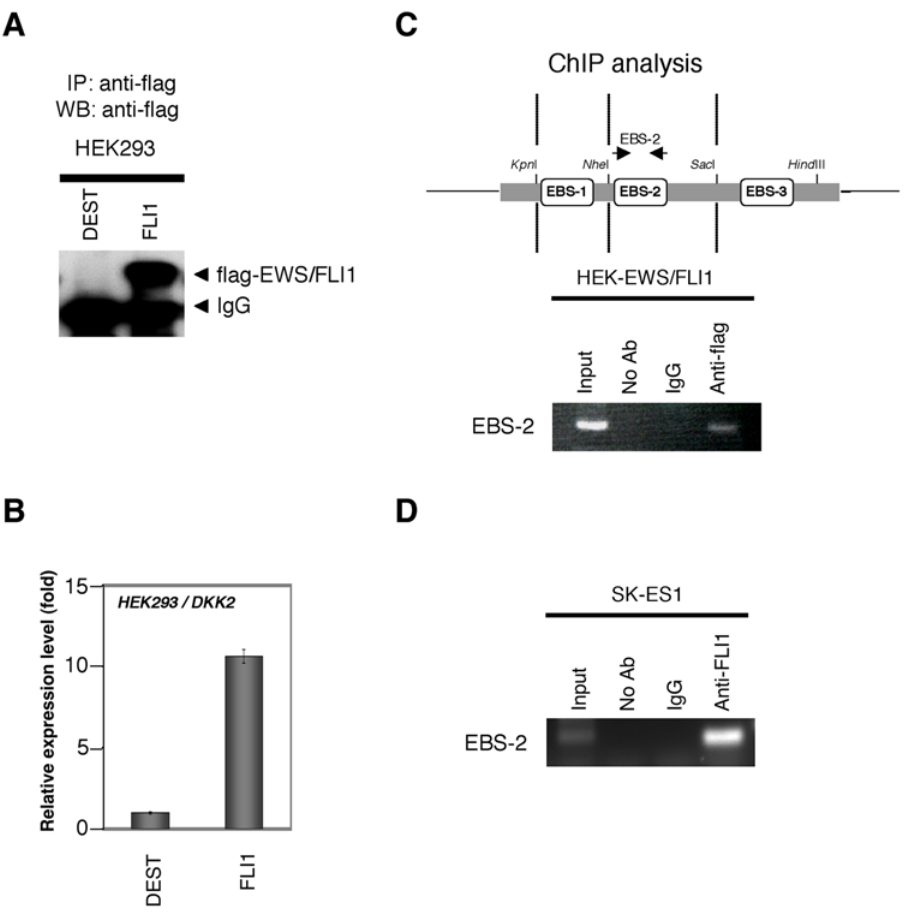
Figure 4. Direct binding of EWS/FLI1 to EBS of the DKK2 promoter. A , Immunoprecipitation (IP) and Western blot analysis of HEK293 cells stably transfected with pcDNA3-flagDEST (HEK-DEST) or pcDNA3-flagEWS/FLI1 (HEK-EWS/FLI1). Cells were lysed and Immunoprecipitated by anti-flag antibodies. The IP products were analyzed by Westen blot analysis. B , Real-time RT-PCR analysis using HEK293 transfectants for DKK2 expression. Data are normalized to the mRNA level in HEK-DEST cells which is arbitrarily set to 1. Signal intensity was normalized using that of a control housekeeping gene (human GAPDH gene). Data are relative values with the SD for triplicate wells. DEST: HEK-DEST cells; FLI1: HEK-EWS/FLI1. C , D , Binding of EWS/FLI1 to EBS of the DKK2 promoter in vivo . The ChIP analysis was done as described under Materials and Methods. For the ChIP analysis using HEK293 transfectants, soluble chromatin was immunoprecipitated with anti-flag antibodies or normal mouse immunoglobulin (IgG) and analyzed by PCR. For the ChIP analysis using SK-ES1 cells, soluble chromatin was immunoprecipitated with anti-FLI1 antibodies or normal